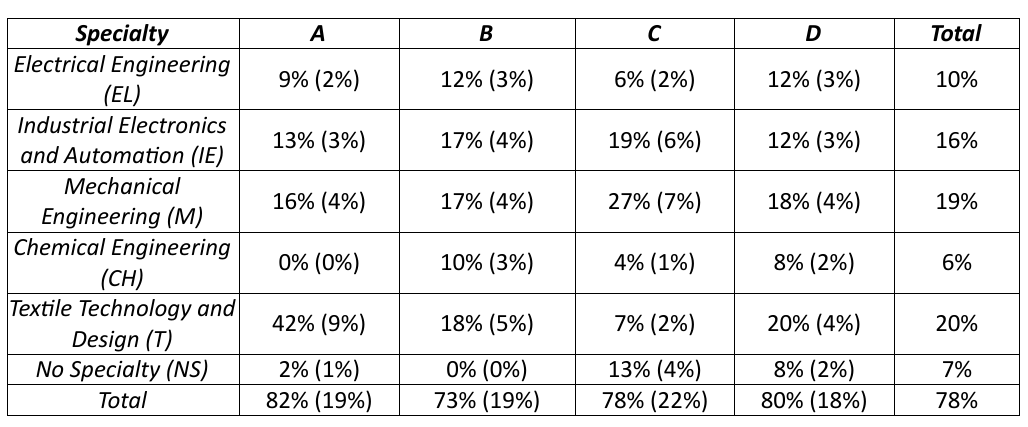
Table 9. Academic year 2013/14 - Percentages of average passing grades (>=5/10 and <8/10), by group and specialty (the percentage of the total is indicated in parentheses)